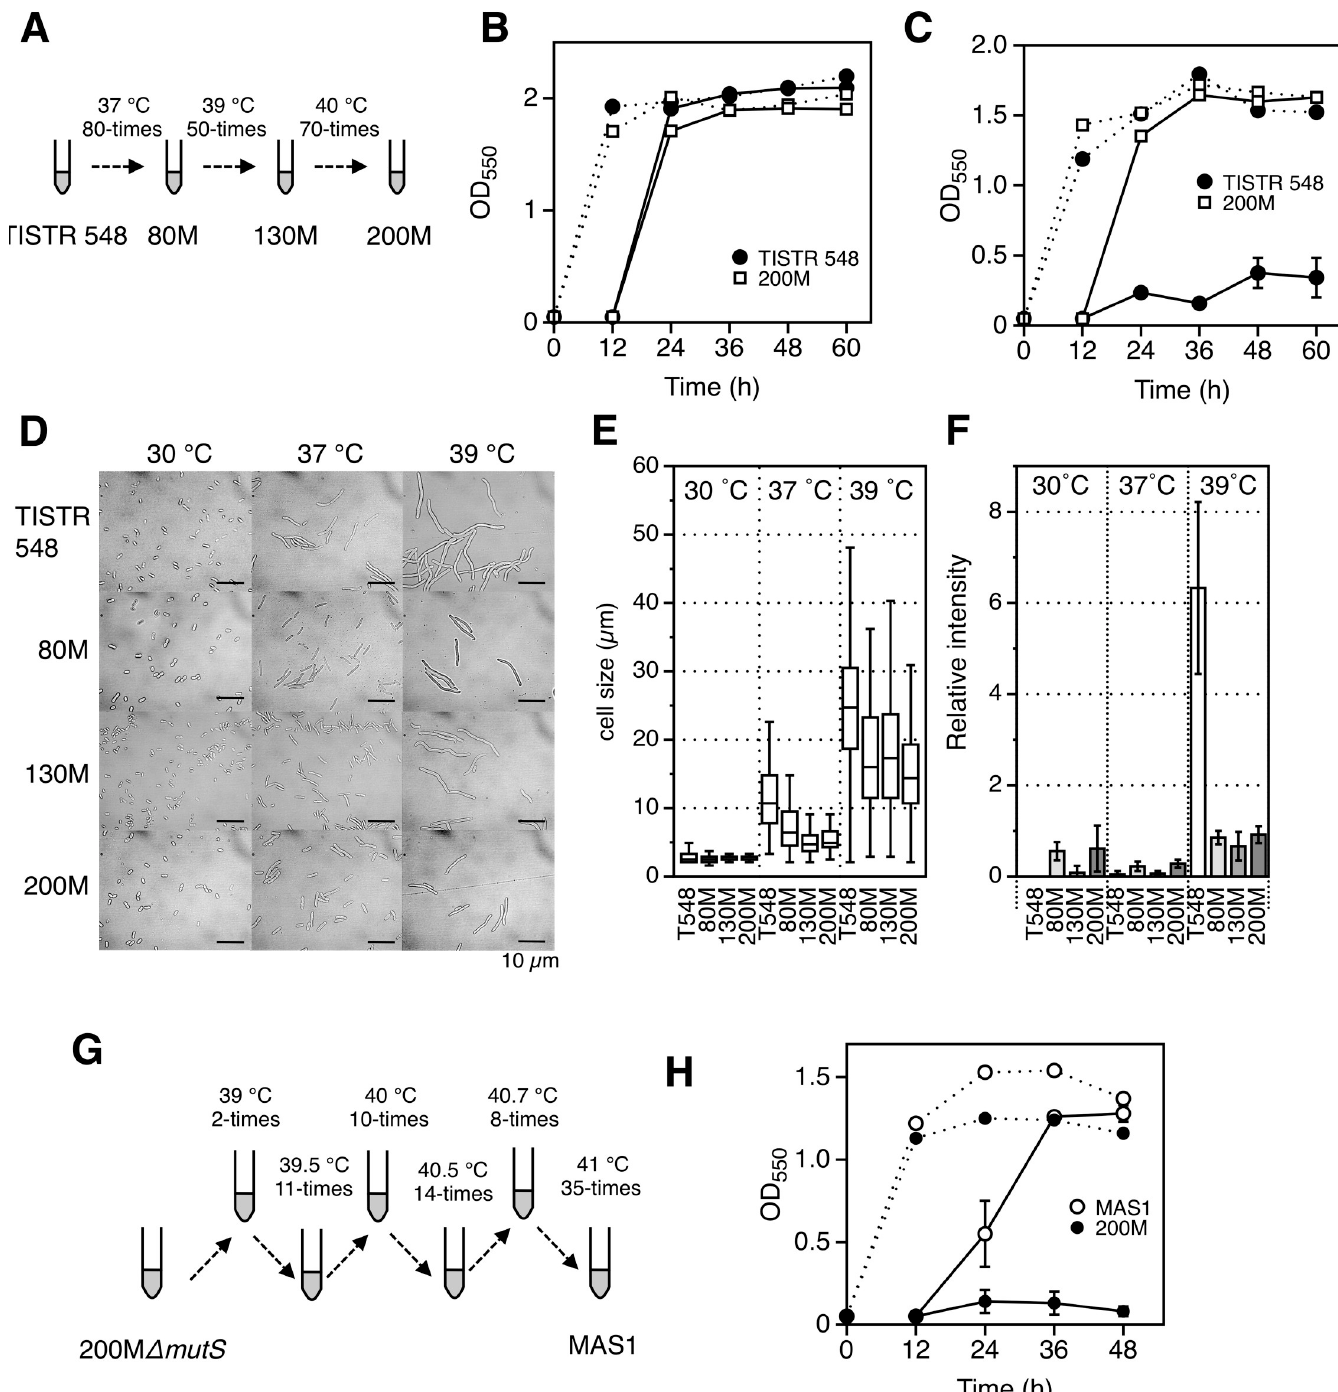
Fig 1. Thermal adaptation of Z . moblis TISTR548 and characteristics of thermoadapted mutants. (A) Z . moblis TISTR548 was thermally adapted as depicted, and detailed description is given in the text and the methods section. (B and C) Two-step cultivation of thermoadapted mutant 200M was performed at 30˚C (B) and 40˚C (C). (D to F) Cell morphology (D), cell size (E) and ROS (F) of thermoadapted mutants, 80M, 130M and 200M, were analyzed. (G and H) 200M Δ mutS was thermally adapted as depicted (G) and two-step cultivation of the mutant, MSA1, was performed at 41˚C (H).